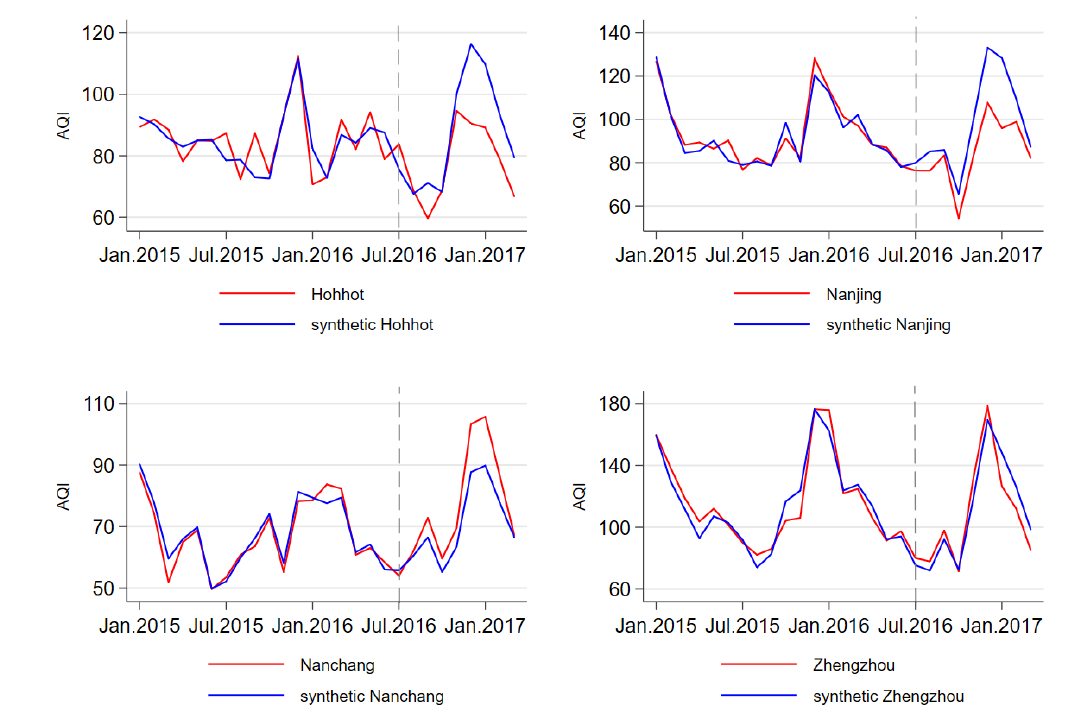
Figure 2. Trends in AQI: treatment regions and synthetic control